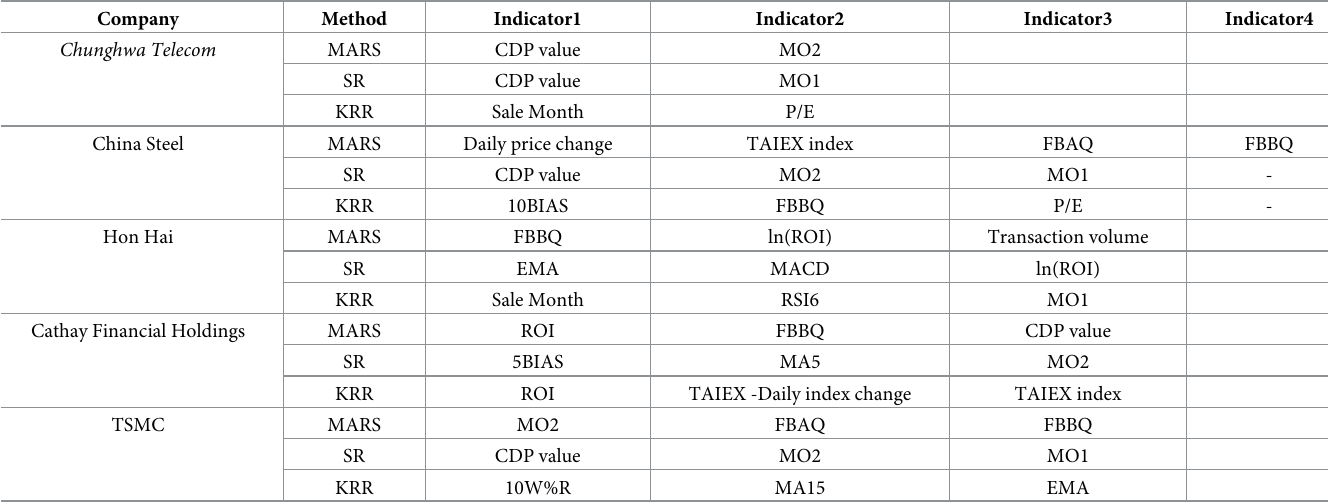
Table 6. Selected features by MARS, SR and KRR for five companies.